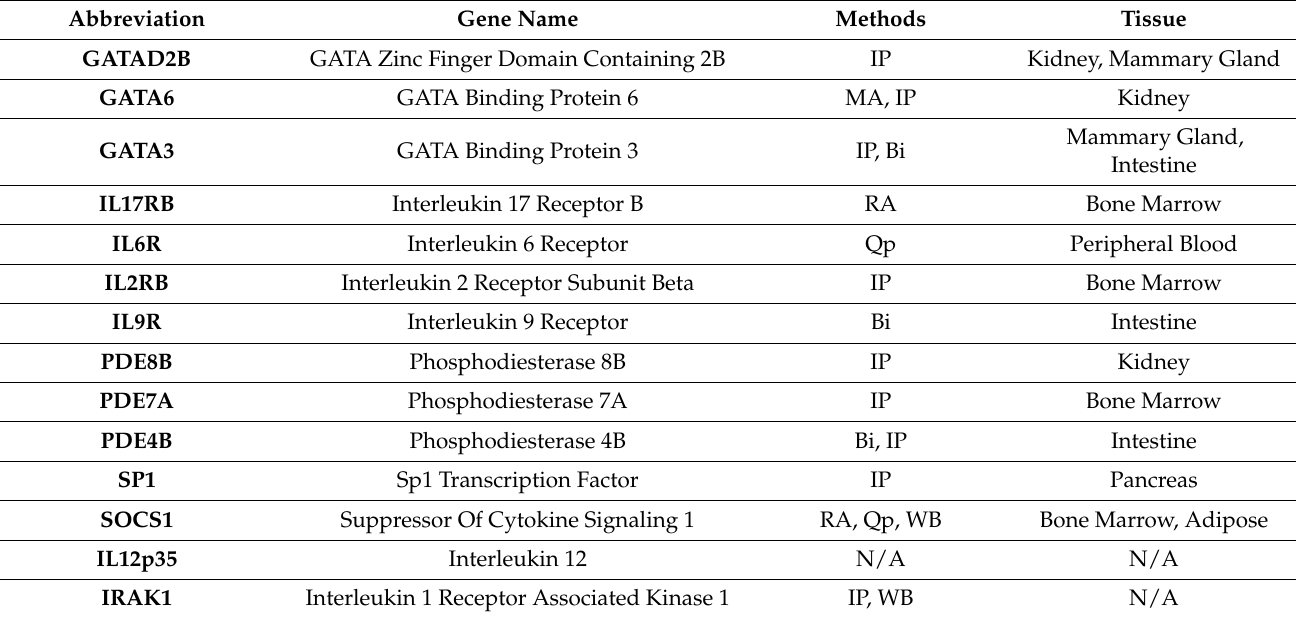
Table 5. Abbreviations, gene names, methods and tissue of